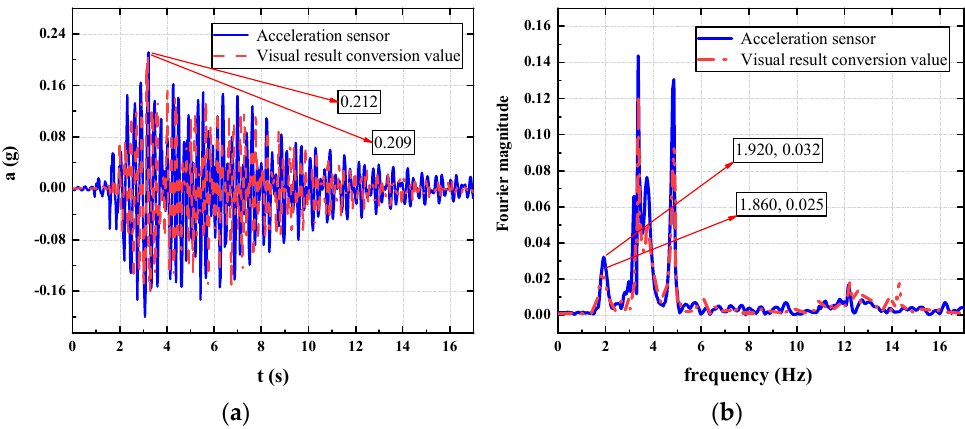
Figure 7. Acceleration comparison chart. ( a ) Acceleration time-domain comparison chart; ( b ) accel- eration frequency-domain comparison chart. ation frequency-domain comparison